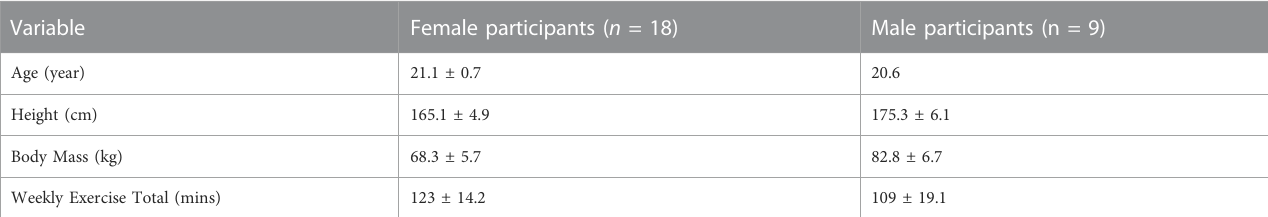
TABLE 1 Demographic data for the participants of this